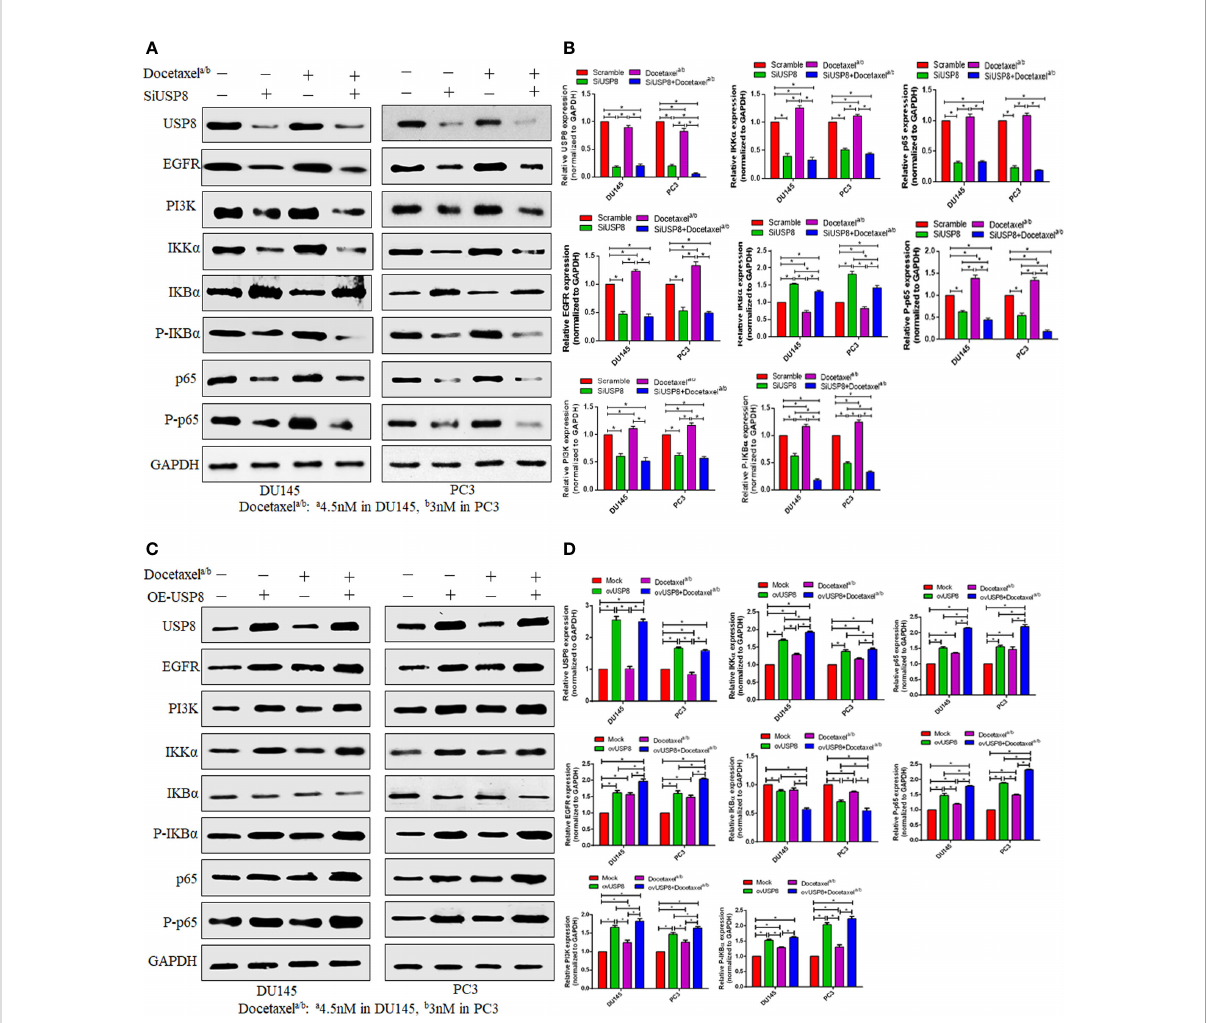
FIGURE 4 USP8 regulates the NF- k B pathway and docetaxel-mediated NF- k B activation in PCa. (A) The DU145 and PC3 cells were transfected or treated with siUSP8 and docetaxel IC 50 individually or combined, and for Western blotting, complete protein was obtained. Antibodies to the indicated proteins (USP8, EGFR, PI3K, IKK a , IKB a , P-IKB a , p65, P-p65) were used to detect their expression. As a control, GAPDH was employed. (B) ImageJ was used to compute the relative gray value of the blots. The results were standardized using GAPDH as a loading control (individual protein/GAPDH) and shown as mean ± SD from three replicated experiments (n = 3, * p < 0.05). (C) The DU145 and PC3 cells were treated with USP8-overexpressing plasmid and docetaxel IC 50 individually or combinedly, and for Western blotting, complete protein was obtained. Antibodies to the indicated proteins (USP8, EGFR, PI3K, IKK a , IKB a , P-IKB a , p65, P-p65) were used to detect their expression. As a control, GAPDH was employed. (D) ImageJ was used to compute the relative gray value of the blots. The results were standardized using GAPDH as a loading control (individual protein/ GAPDH) and shown as mean ± SD from three replicated experiments (n = 3, * p <